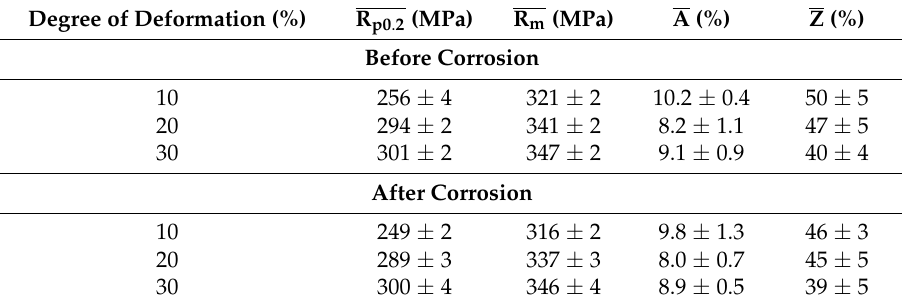
Table 3. Mechanical properties of AlZnMg0.8Zr alloy, subjected to LTTT, obtained after and before stress corrosion tests.